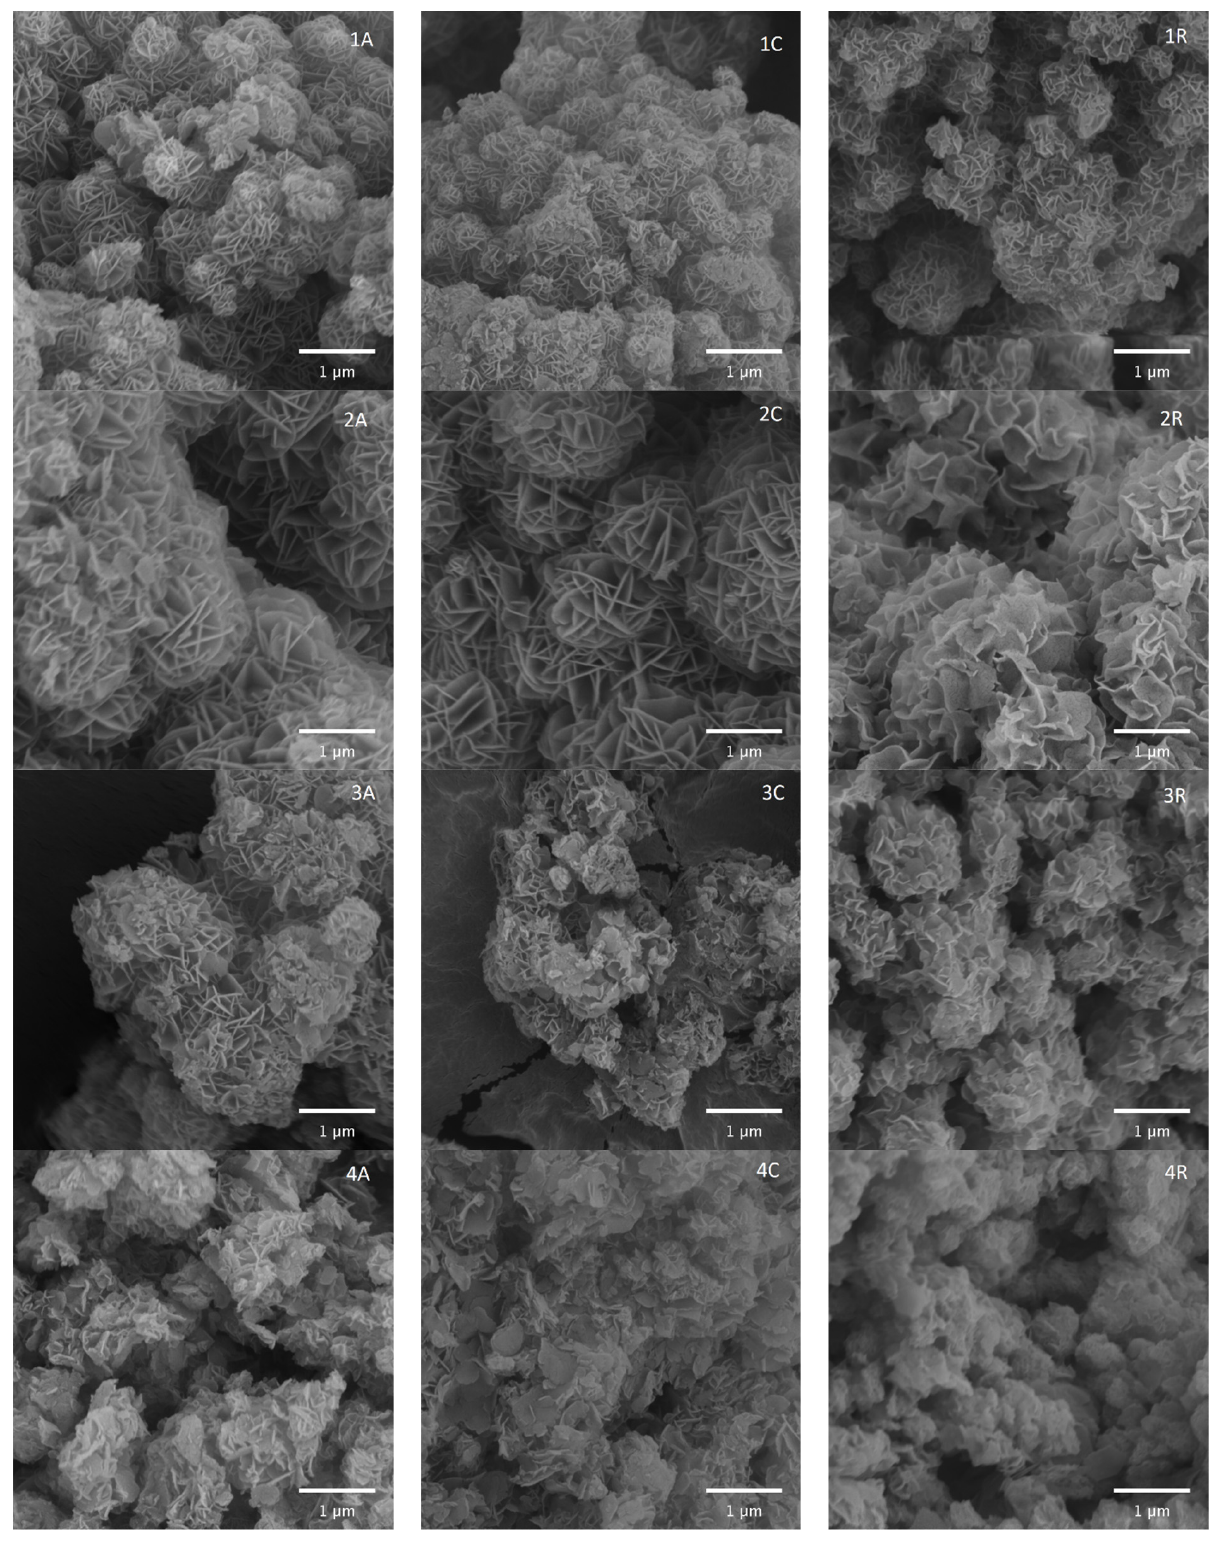
Figure 2. Scanning electron micrographs of the prepared samples: 1—MgAl, 2—MgGa, 3—MgFe, 4—MgIn. A—as-prepared, C—calcined, R—rehydrated for 20 min.